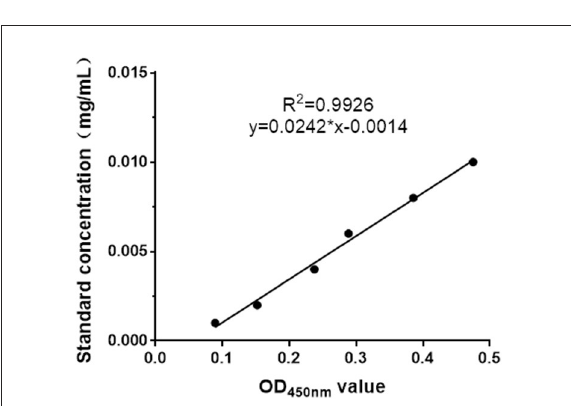
FIGURE4 BCA standard curve drawing. BSA dilution concentrations ranged from 0.001 to 0.01 mg/mL. The BCA standard curve indicates that the linear correlation of the protein concentration and OD 450nm value was y = 0.0242x-0.0014 ( R 2 = 0.9926).